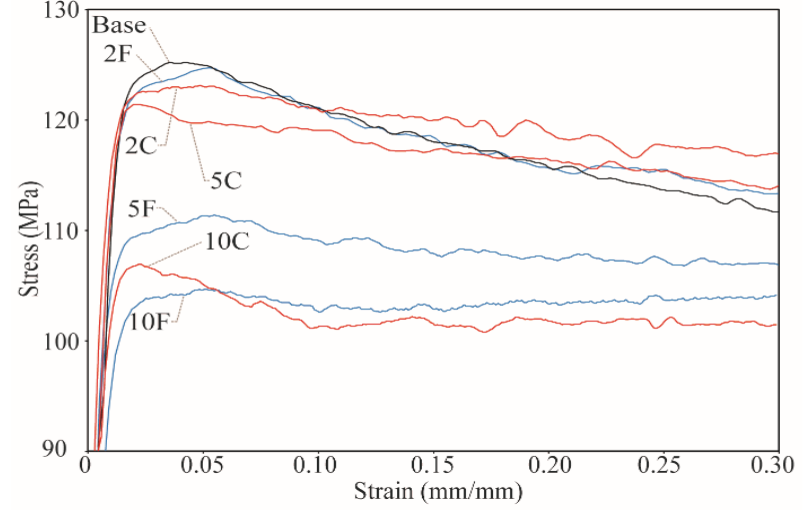
Figure 8. Flow curves for each material composition deformed at 350 °C and 0.05 s −1 exhibiting the variation in peak flow stress.